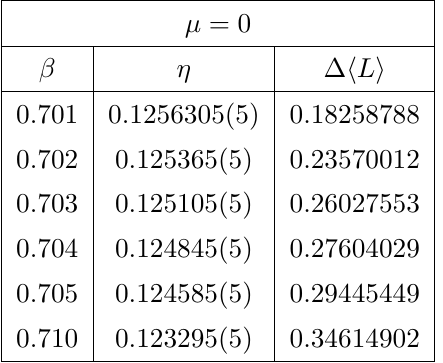
Table 1 . ∆ h L i and the first-order transition points ( β, η ) at µ = 0 on a 1024 3 lattice.